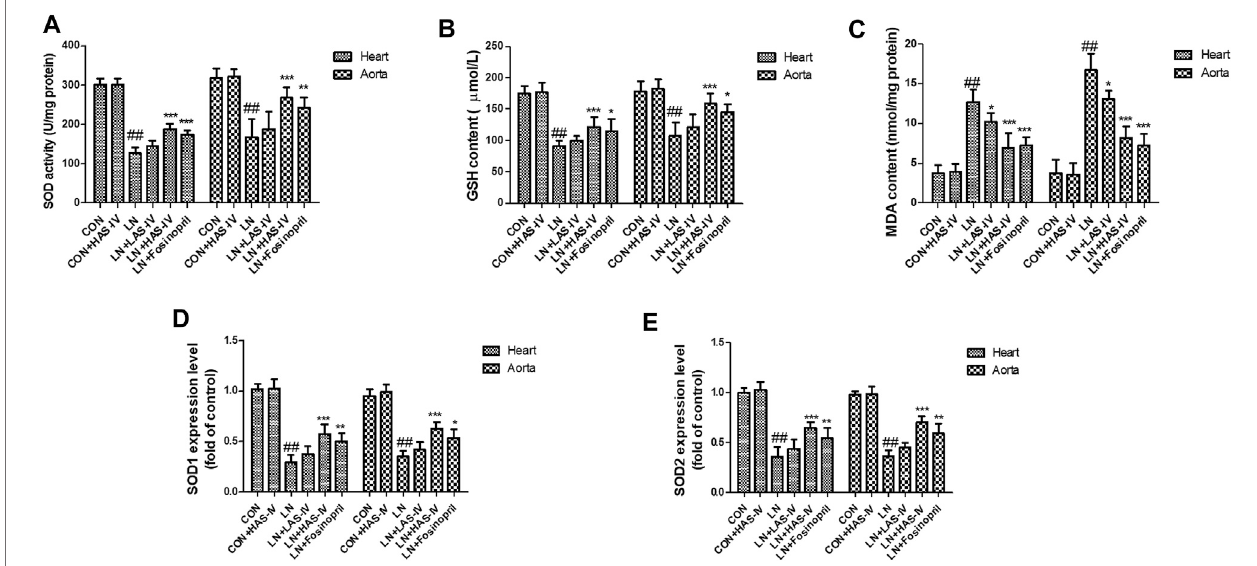
FIGURE9| EffectsofAstragalosideIV(AS-IV)onoxidativestressbiomarkersinhypertensiveratsevokedbyL-NAME.TheSODactivity (A) ,GSHcontent (B) ,MDA content (C) , SOD1 mRNA expression (D) , and SOD2 mRNA expression (E) in CON, CON + HAS-IV, LN, LN +LAS-IV, LN + HAS-IV and LN + fosinopril groups. Results wereshownasmean ± SD( n (cid:1) 6foreachgroup).## p < 0.001versusCONgroup,* p < 0.01versusLNgroup;** p < 0.01versusLNgroup;*** p <